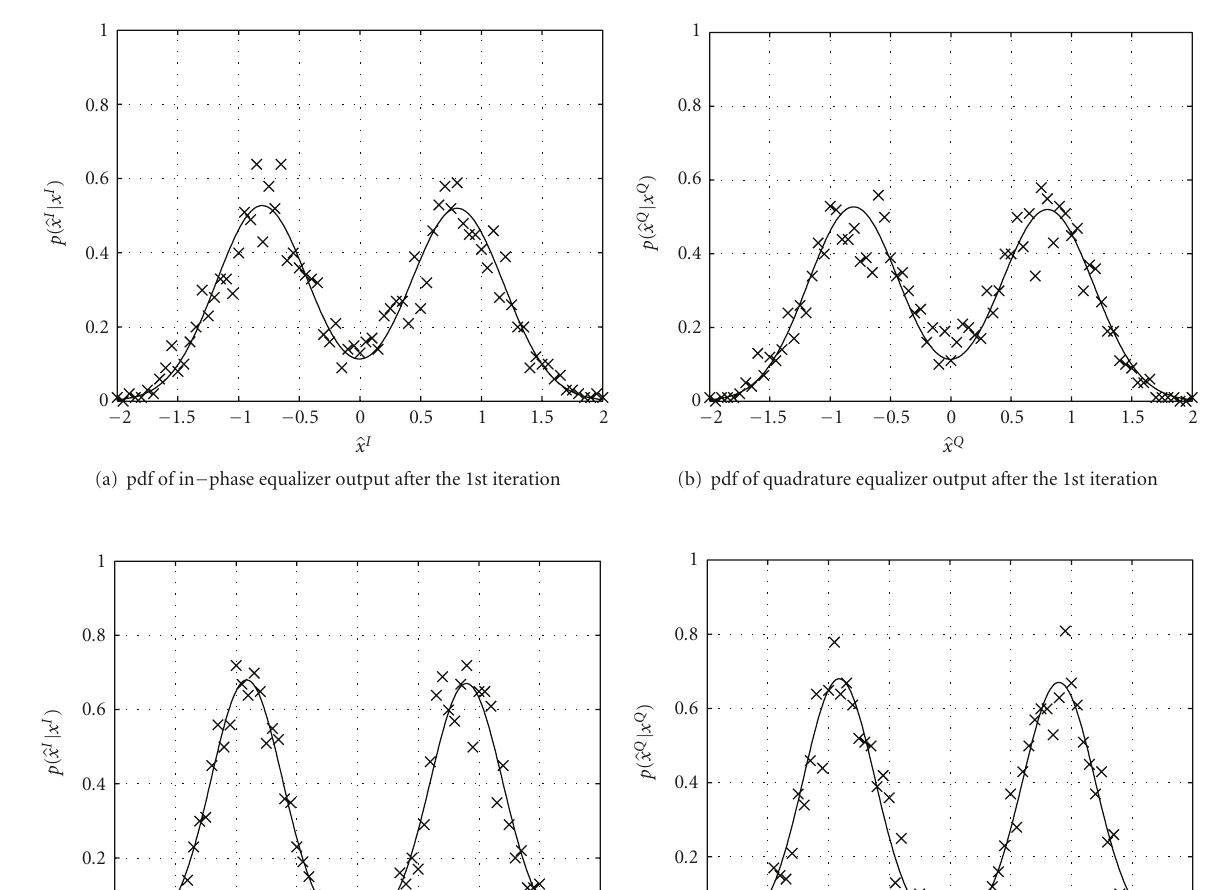
By using (23) and (24), the observed multipath exhibits τ av of 1.4 ms and τ rms of 1.1 ms. The receiver used in the demodulation of the data consisted of a DFE equalizer with 32 feedforward taps ( T/ 2-spaced) and 10 feedback taps. The first few packets were decoded error free for the 1st iteration itself without employing adaptive Doppler correction. However, many packets resulted in BER of